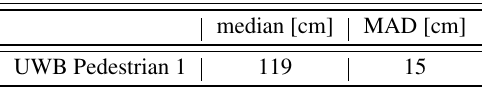
Figure 8. LiDAR-based positioning error distribution along the (a) x and (b) y axes for Pedestrian